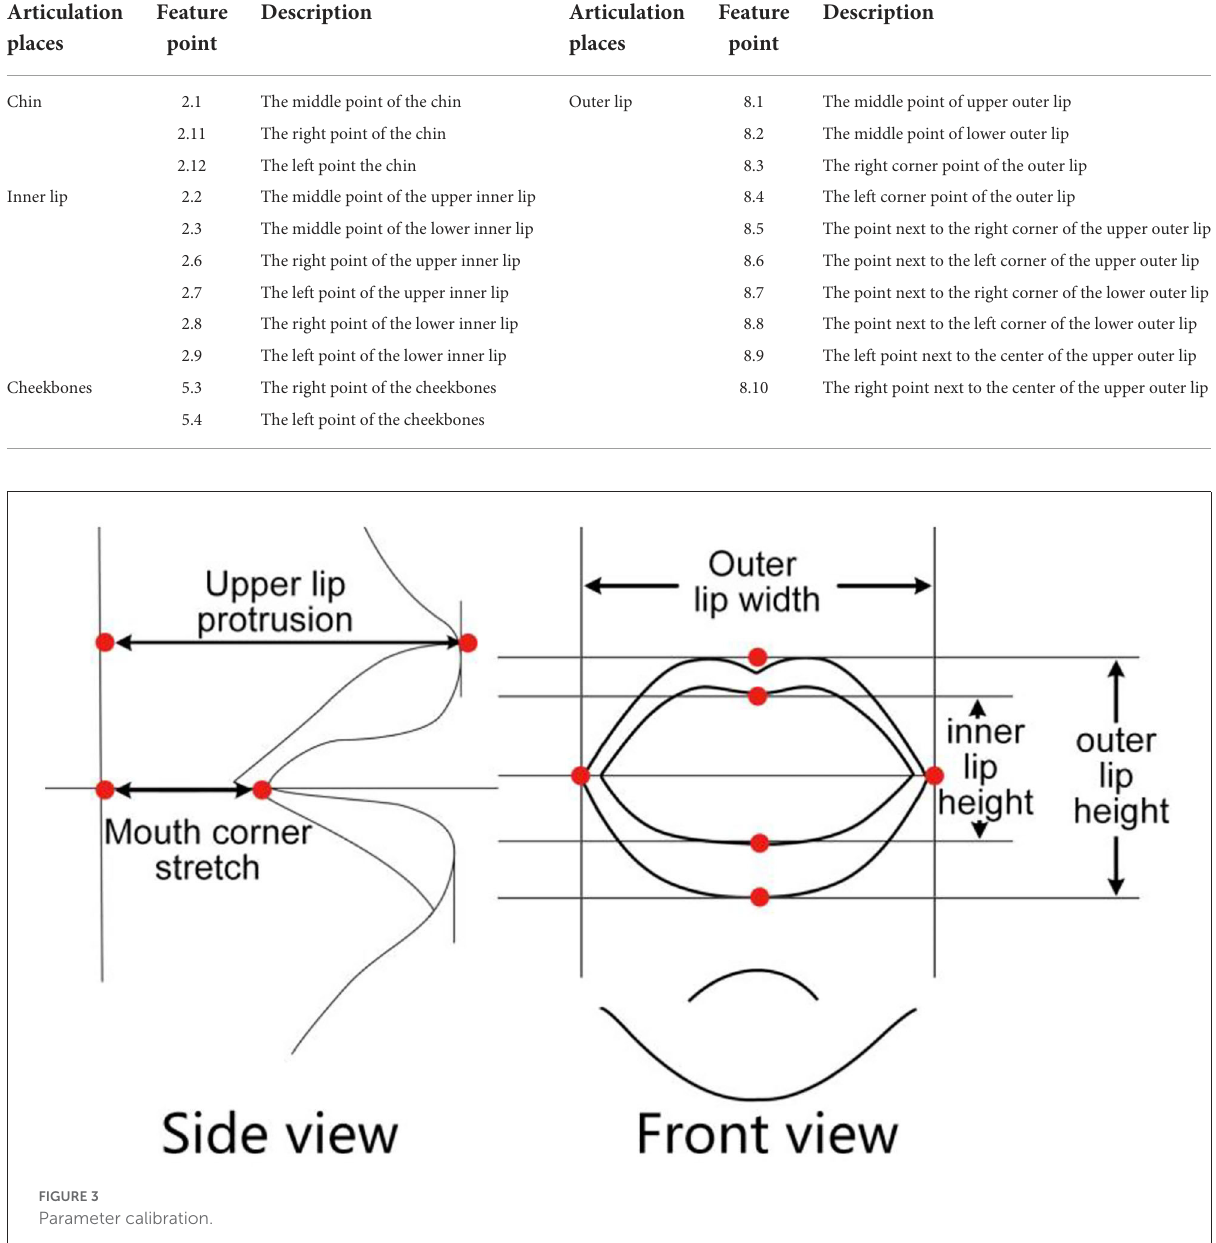
TABLE 1 The description of FDP.